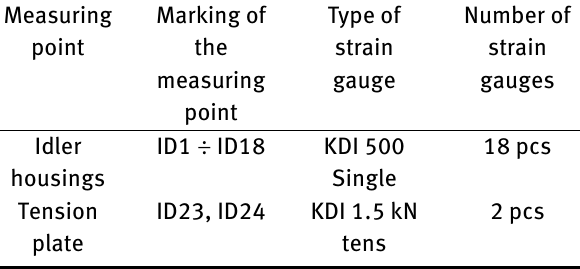
Figure 3: Marking the positions of strain gauges on idler housings No.1, No.1, No.3 [12] Table 1: The characteristics of strain gauges Measuring